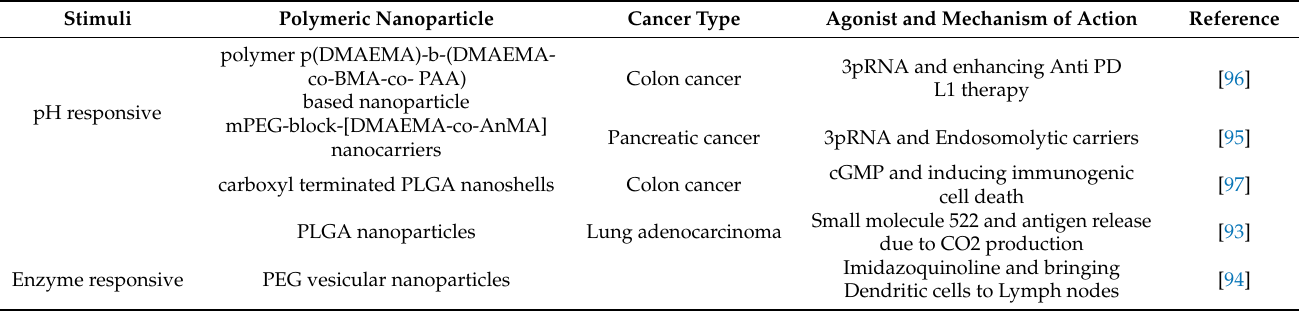
Table 6. Endogenous stimuli-based polymer nanoparticles for delivery of